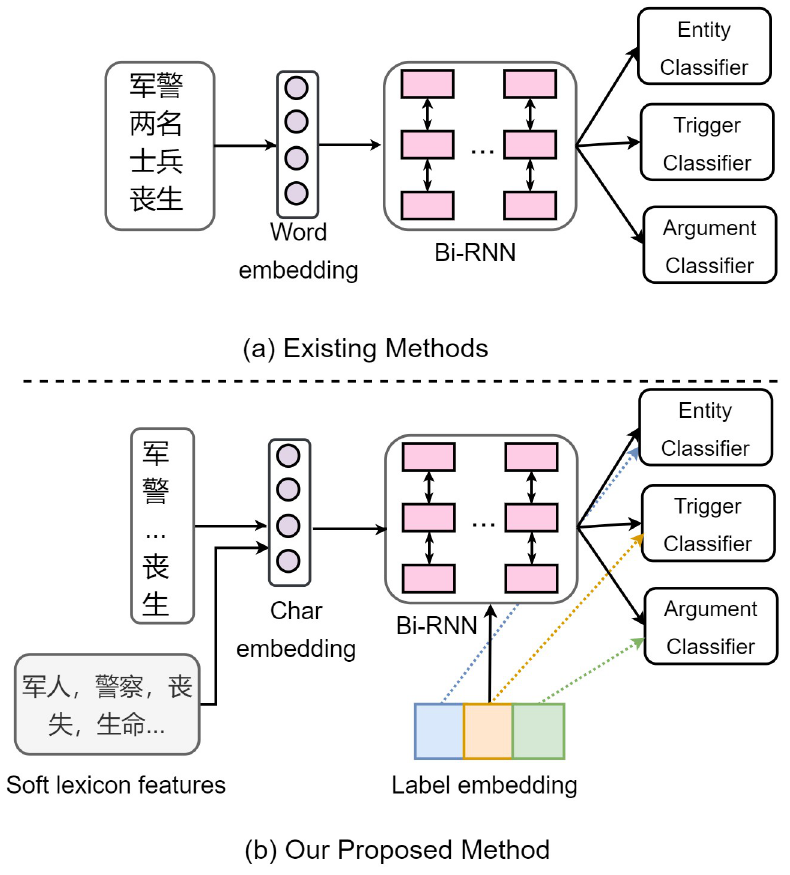
Fig 1. Illustration of comparison of existing methods and our proposed method for an input Chinese sentence “ 军 警两名士兵丧生 (Two military soldiers were killed)”.